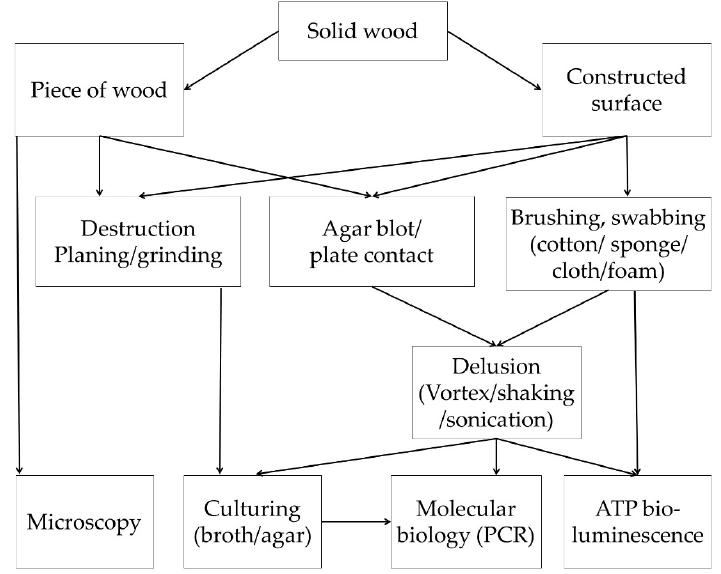
Figure 5. Flow diagram outlining review findings on the methods to study microbial survival on solid wood material.